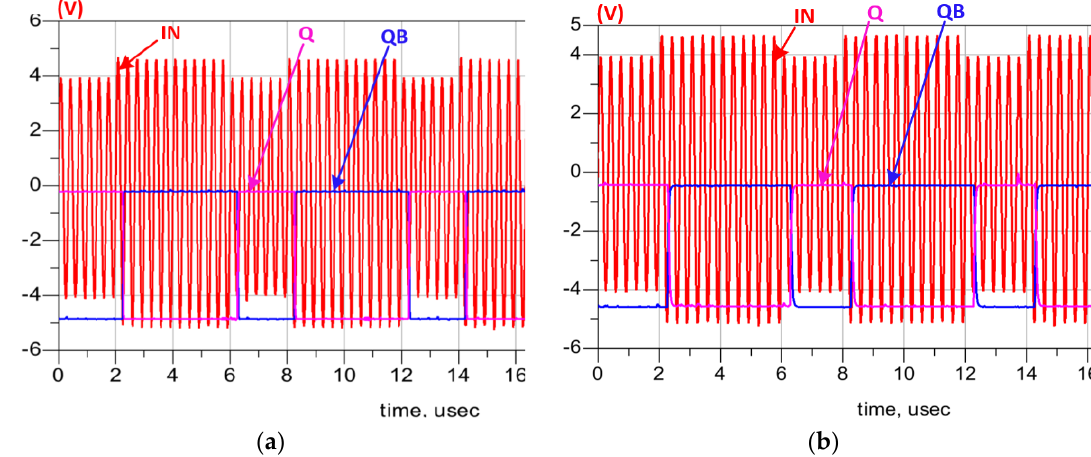
Figure 14. Demodulator simulation results of input/output signals at: ( a ) 25 °C; ( b ) 350 °C.